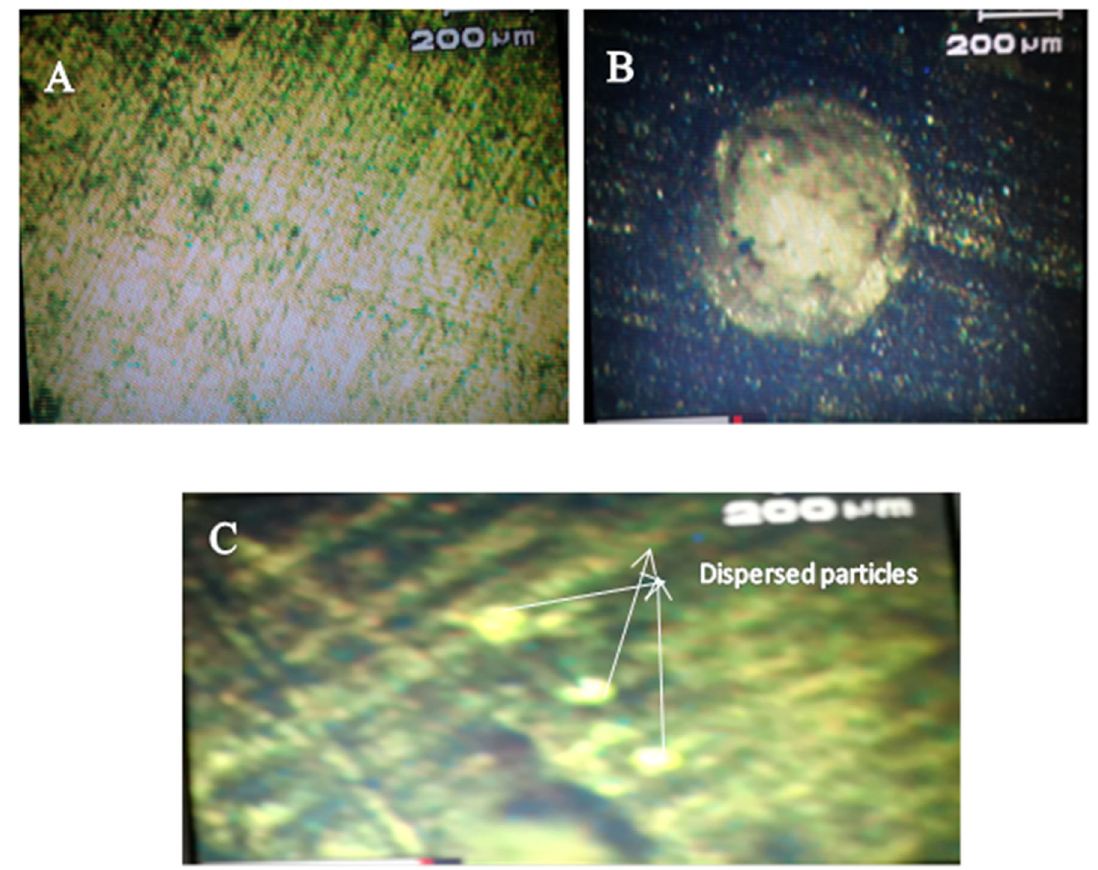
Fig. 5 Microscopic images of A AR, B C m C, and C hybrid